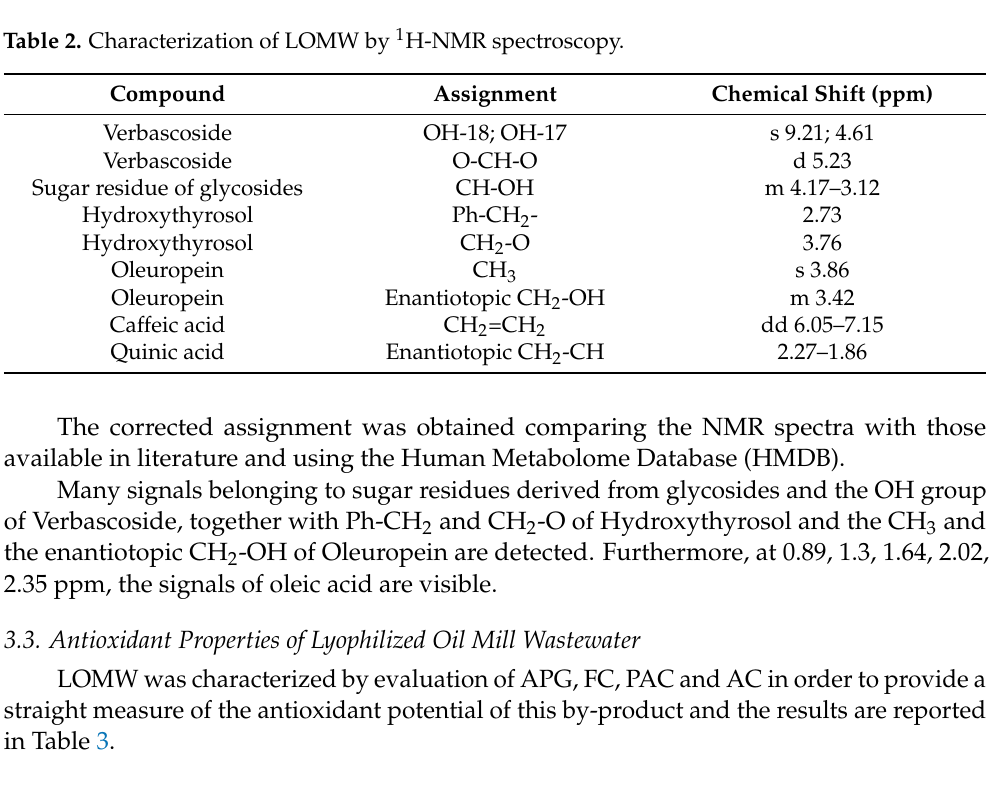
Table 3. Antioxidant characterization of LOMW. Data represent mean ± RSD ( n = 3).